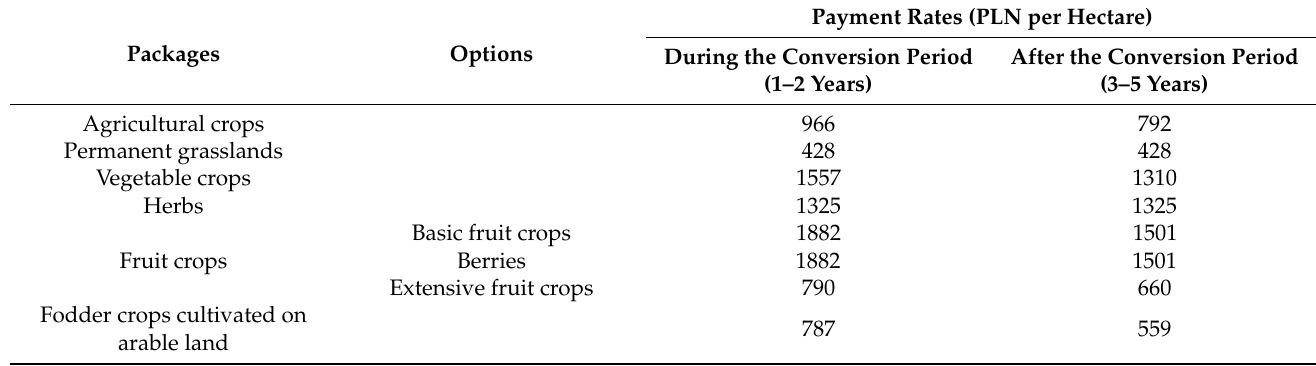
Table 5. Organic payment rates under the 2014–2020 RDP.